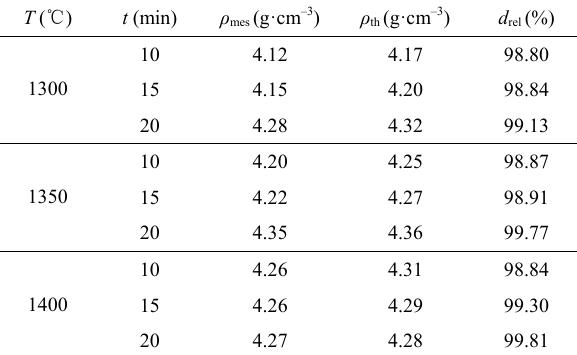
Table 2 Experimental conditions adopted during the SPS process and the corresponding values of densities (where T indicates sintering temperature; t soaking time, ρ mes measured density of the compacted sample,